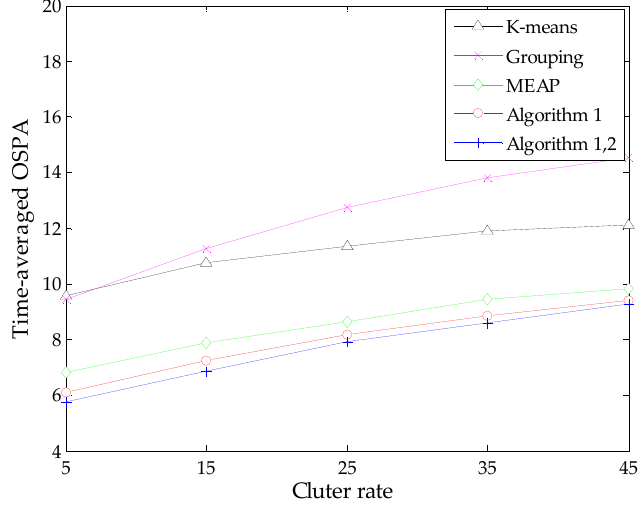
Figure 6. Time-averaged OSPA distance versus clutter rate ( p D = 0.90).